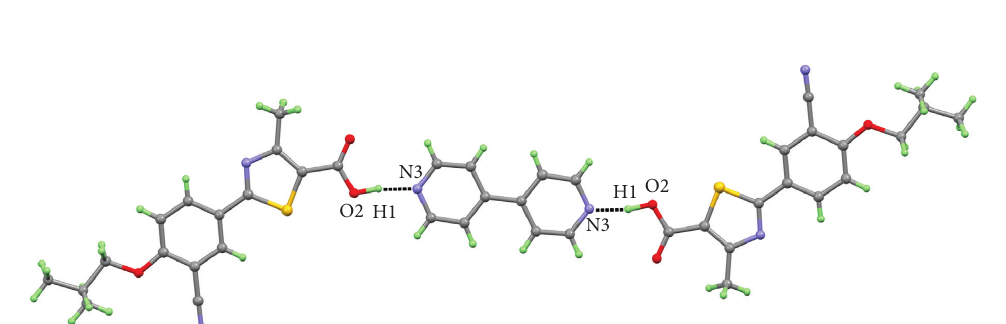
Figure 2: The parallel chain structures of FEB-BIP cocrystal.